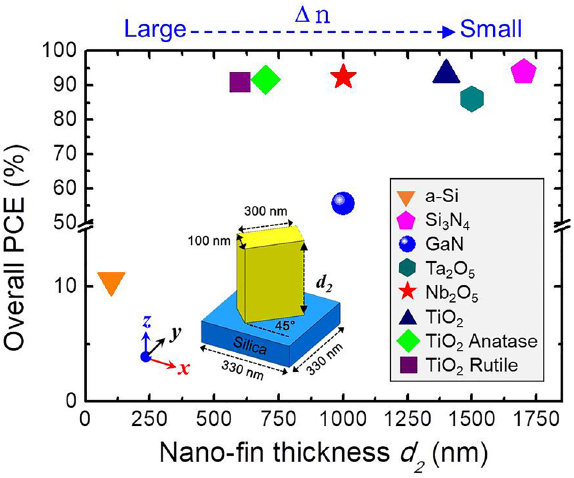
Figure 4. Overall PCE comparison. Optimized thickness ( d 2 ) of a nano-fin for various materials at the highest overall PCE. The geometric diagram of a meta-atom is shown in inset.